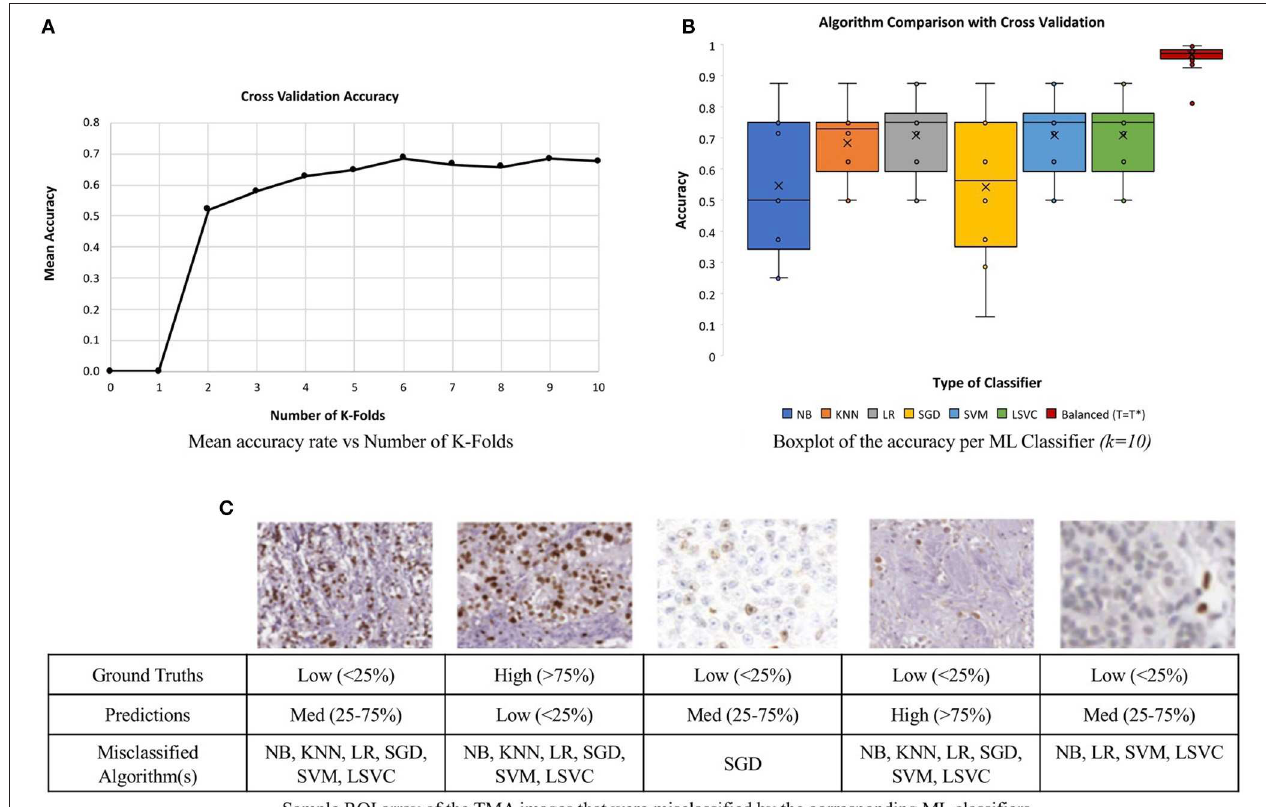
FIGURE 12 | Comparison of six machine learning classifiers to the unsupervised approach on a multi-institutional dataset of 80 Ki67 TMAs. (A) Mean classification accuracy of all six classifiers as a function of k in for CV. (B) Classification accuracy for each classifier. (C) Array of ROI images from misclassified TMAs with labels and the predicted classification.